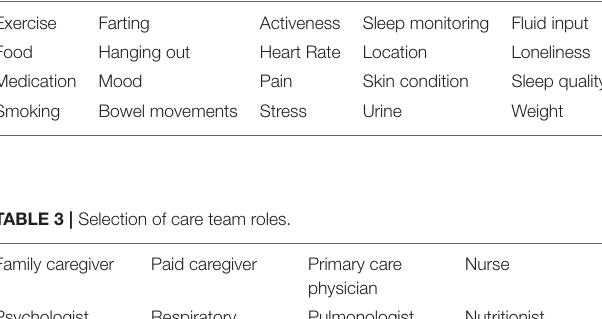
TABLE 2 | Selection of patient-generated health data (PGHD) types.